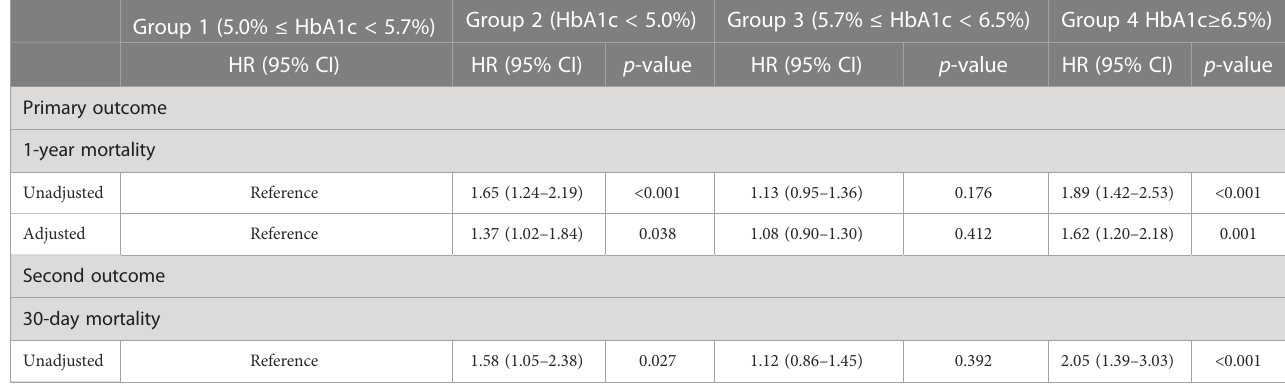
TABLE 2 Univariate and multivariate analysis of the associations between outcomes and different ranges of hemoglobin A1c.